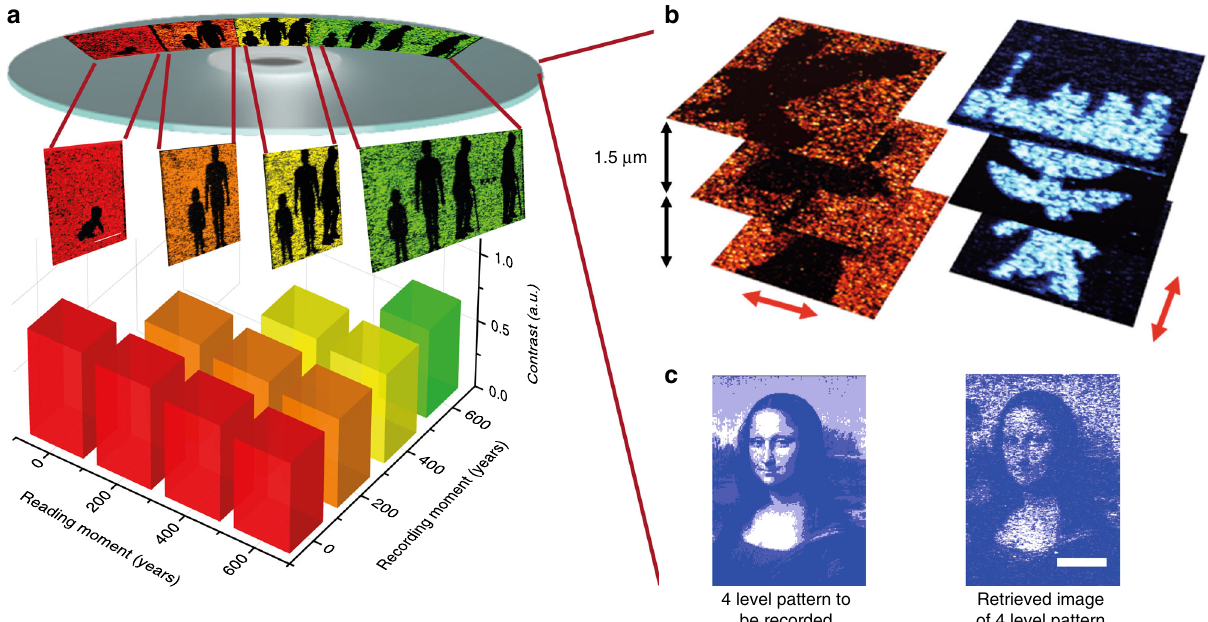
Fig. 4 Century-long unchanged baseline in recording and reading processes of optical long data memory. a Contrast of the fl uorescent images of the patterns at different recording and reading moments. Inset: Fluorescent images of the recorded patterns after aging over 0, 200, 400, and 600 years. Scale bar: 10 µ m. b Multiplexed optical data memory with two polarization states in three layers spaced by 1.5 μ m. The red arrow indicate the